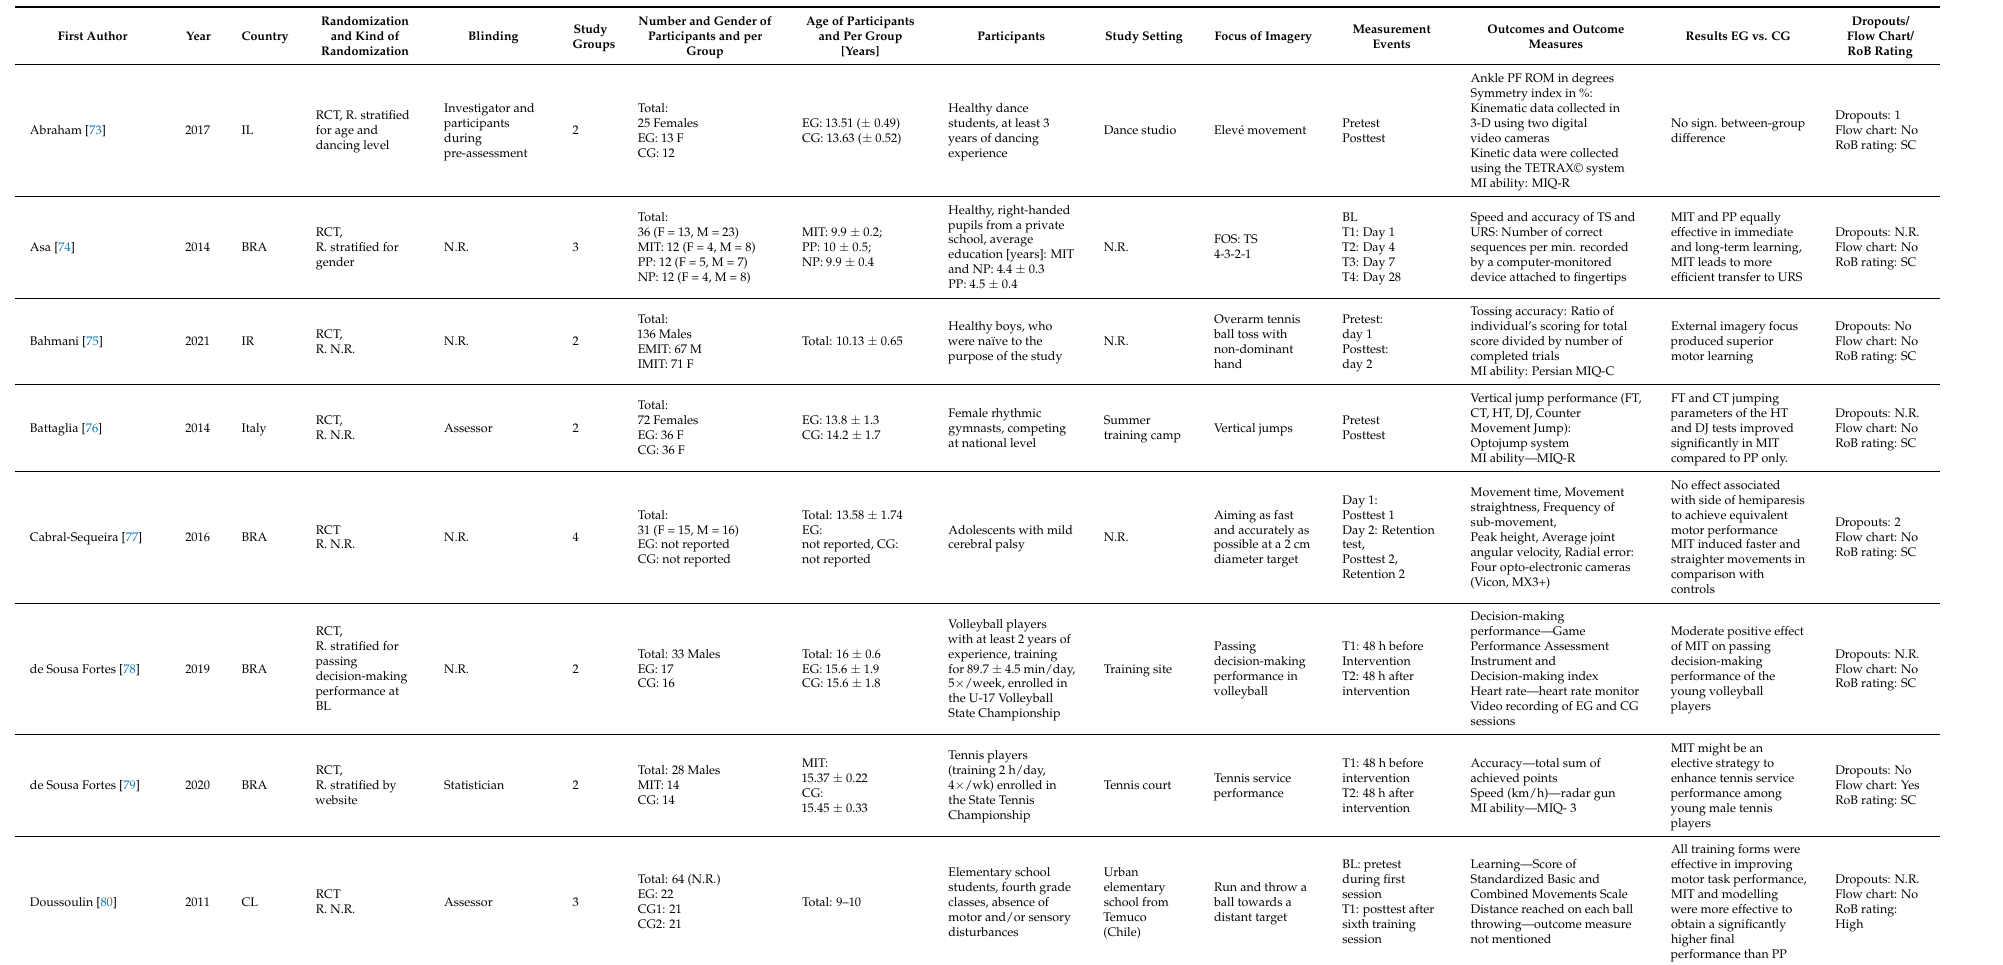
Table 2. Characteristics of included